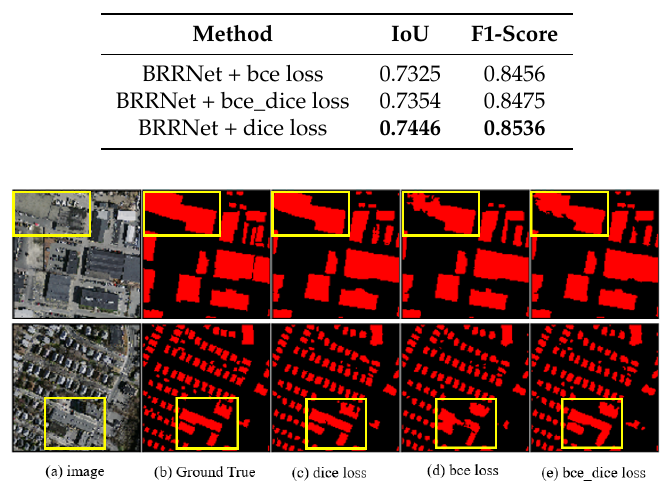
Figure 6. Typical results of different loss functions: ( a ) input image; ( b ) ground truth; ( c ) the result of Dice loss; ( d ) the result of BCE loss; and ( e ) the result of the sum of BCE loss and Dice loss. The areas in the yellow boxes are the more obvious